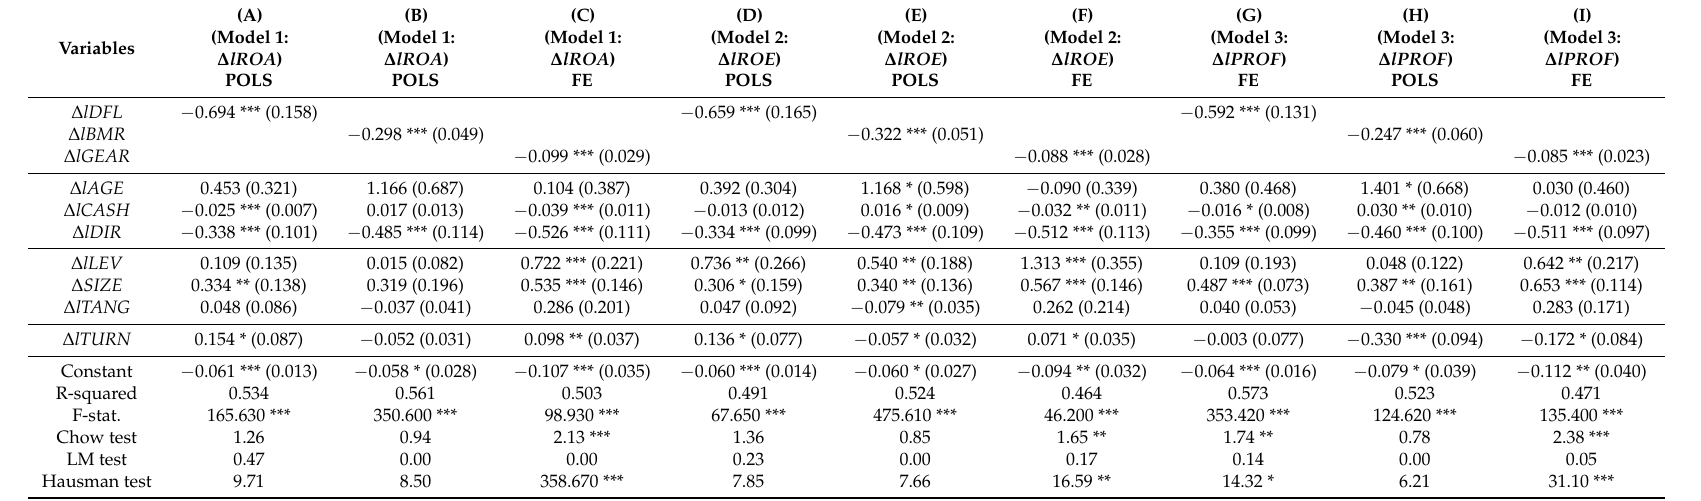
Table 5. Robustness using a single measure of market risk with Driscoll and Kraay’s standard